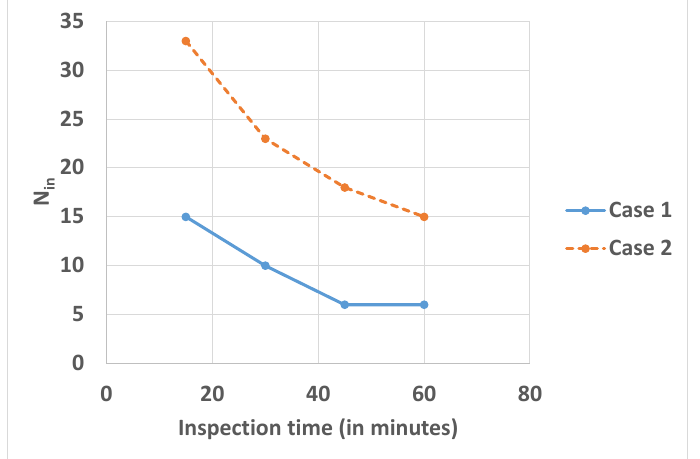
Figure 6. Variation of the optimal N in in terms of inspection time: case 1 vs. case